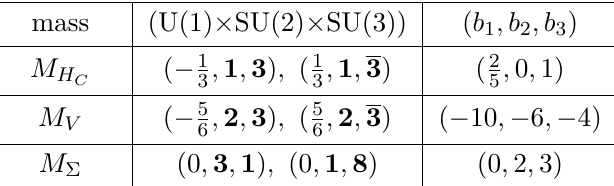
Table 1 . The GUT mass spectrum and the contribution to the (cid:12) -function coe(cid:14)cients in the Minimal SU(5) model.